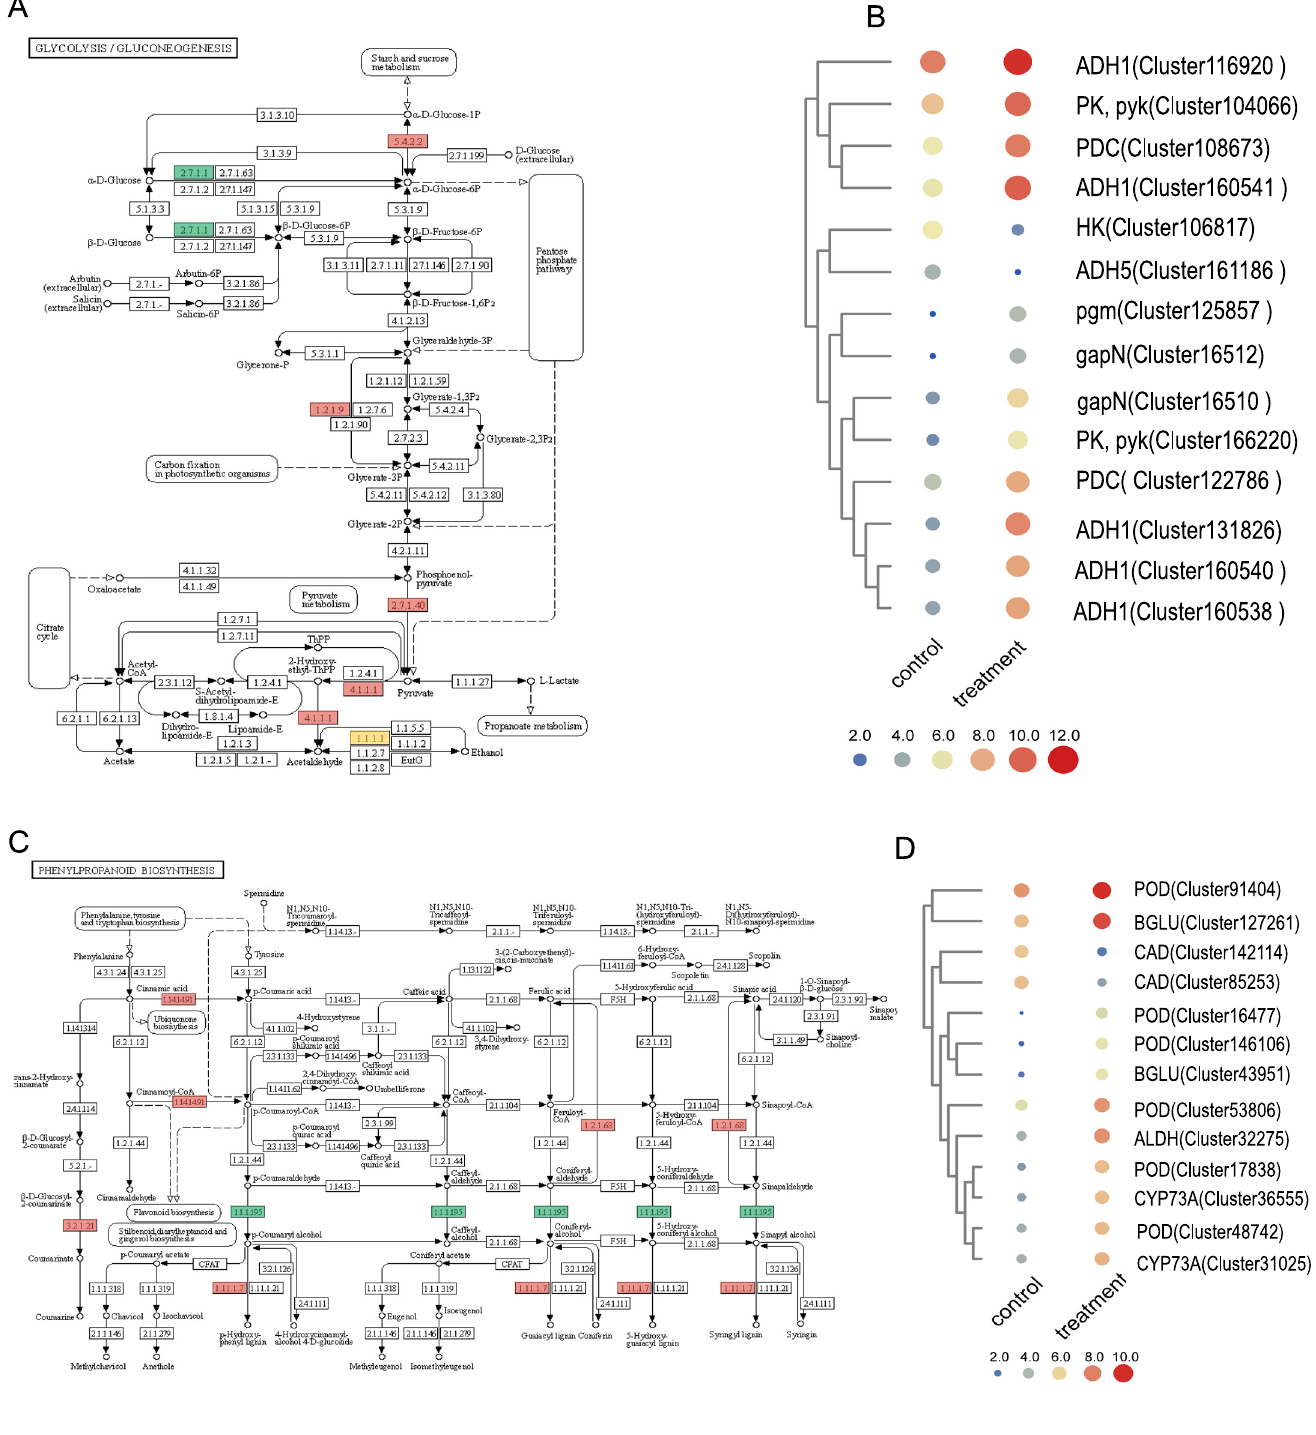
Fig 7. Phenylpropanoid and glycolysis/gluconeogenesis pathway related DEGs. (A) Map of glycolysis/gluconeogenesis pathway; (B) Gene clustering heat map participating in the glycolysis/gluconeogenesis pathway; (C) Map of phenylpropanoid pathway; (D): Gene clustering heat map involving in the phenylpropanoid